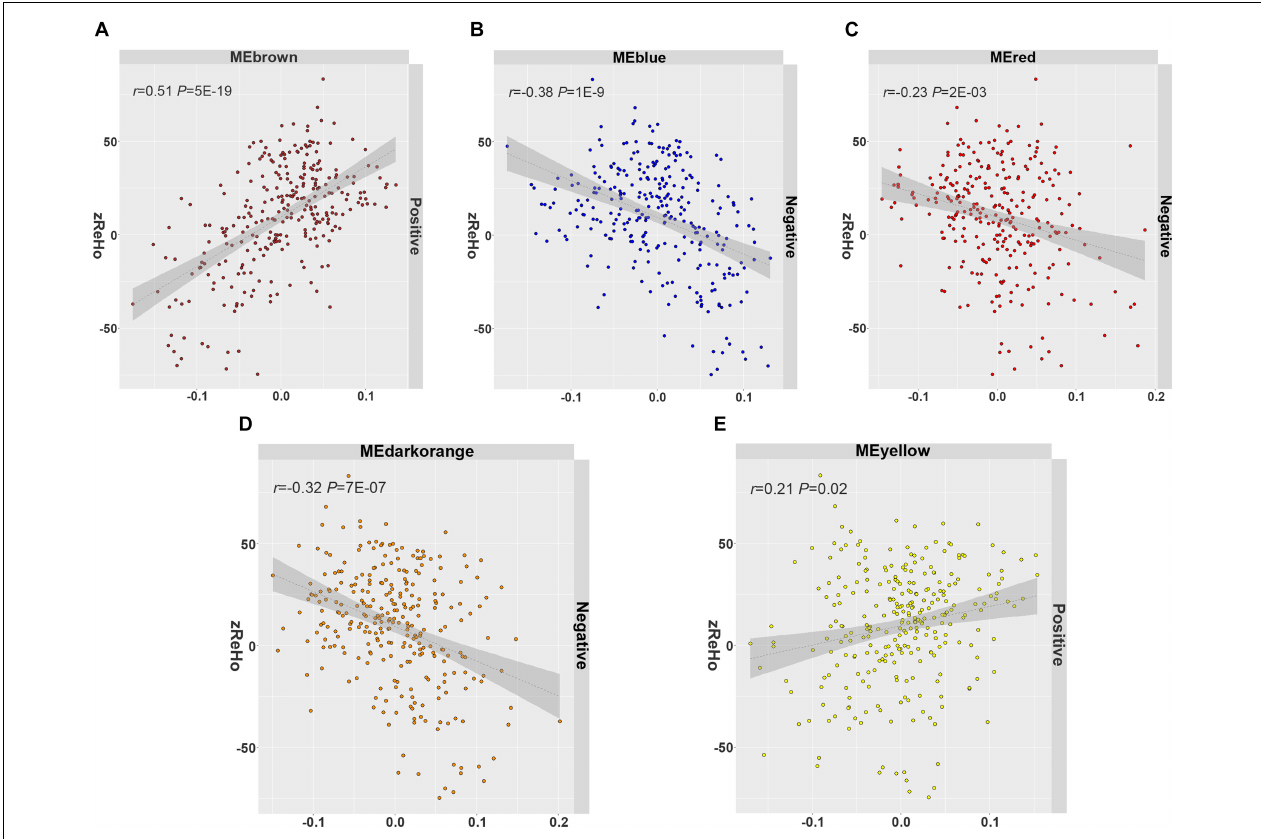
FIGURE 4 | The spatial correlation between the ME and zReHo of each cell-type-specific module with the correlation coefficient and Bonferroni-corrected P values. (A) Brown module, (B) blue module, (C) red module, (D) dark orange module, (E) yellow module in the discovery sample. ME, module eigengene; zReHo, z transformed regional